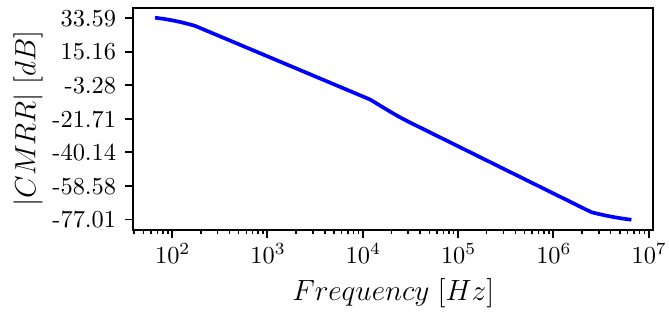
Figure 10. Frequency response of CMRR